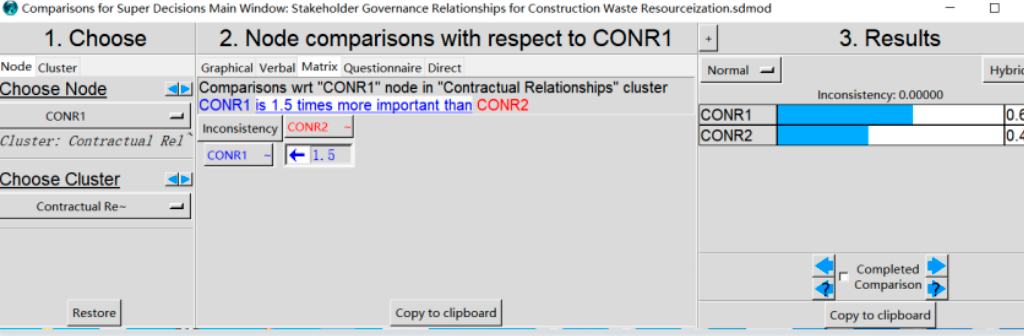
Table 1. Unweighted super matrix.